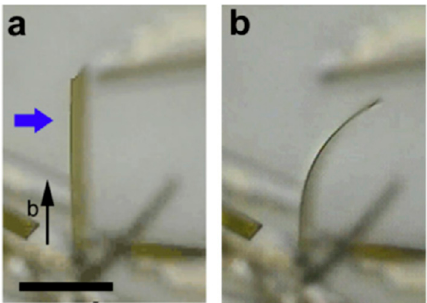
Figure 4. Photomechanical bending of a thin crystal of trans - 2 ( a ) before and ( b ) after UV irradiation. The scale bar is 100 µm. Reprinted with permission from [27]. Copyright 2012 Elsevier.